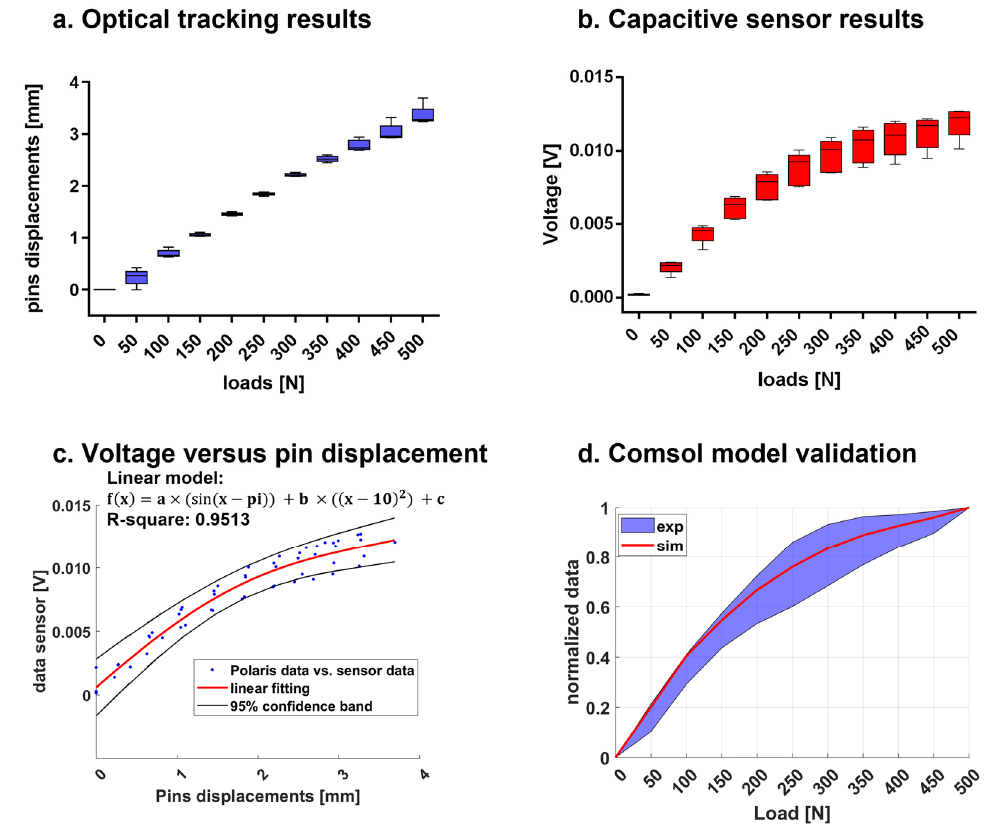
Figure 10. Results of the capacitive sensor technology tests.